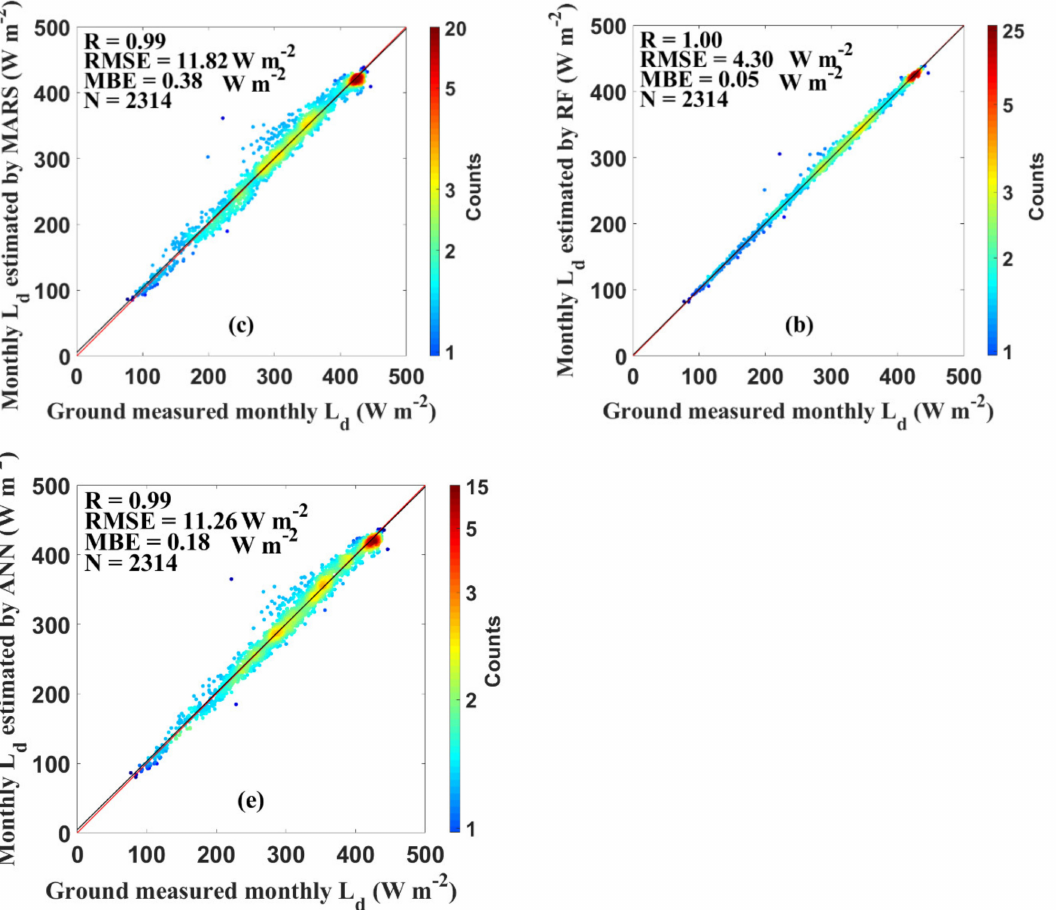
Figure 4. Evaluation results of the monthly L d estimates on the basis of the ( a ) GBRT, ( b ) RF, ( c ) MARS, ( d ) SVR, and ( e ) ANN methods against the ground measurements on the training dataset. N is the number of data records. The red and black lines represent the 1:1 and fitted lines,